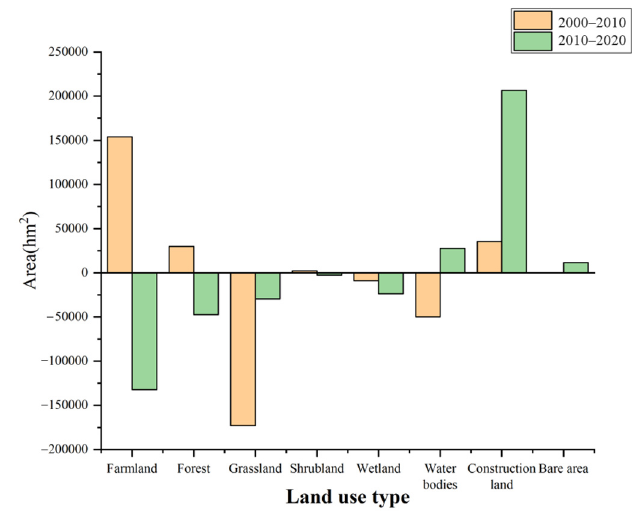
Figure 2. Land use change of study area.